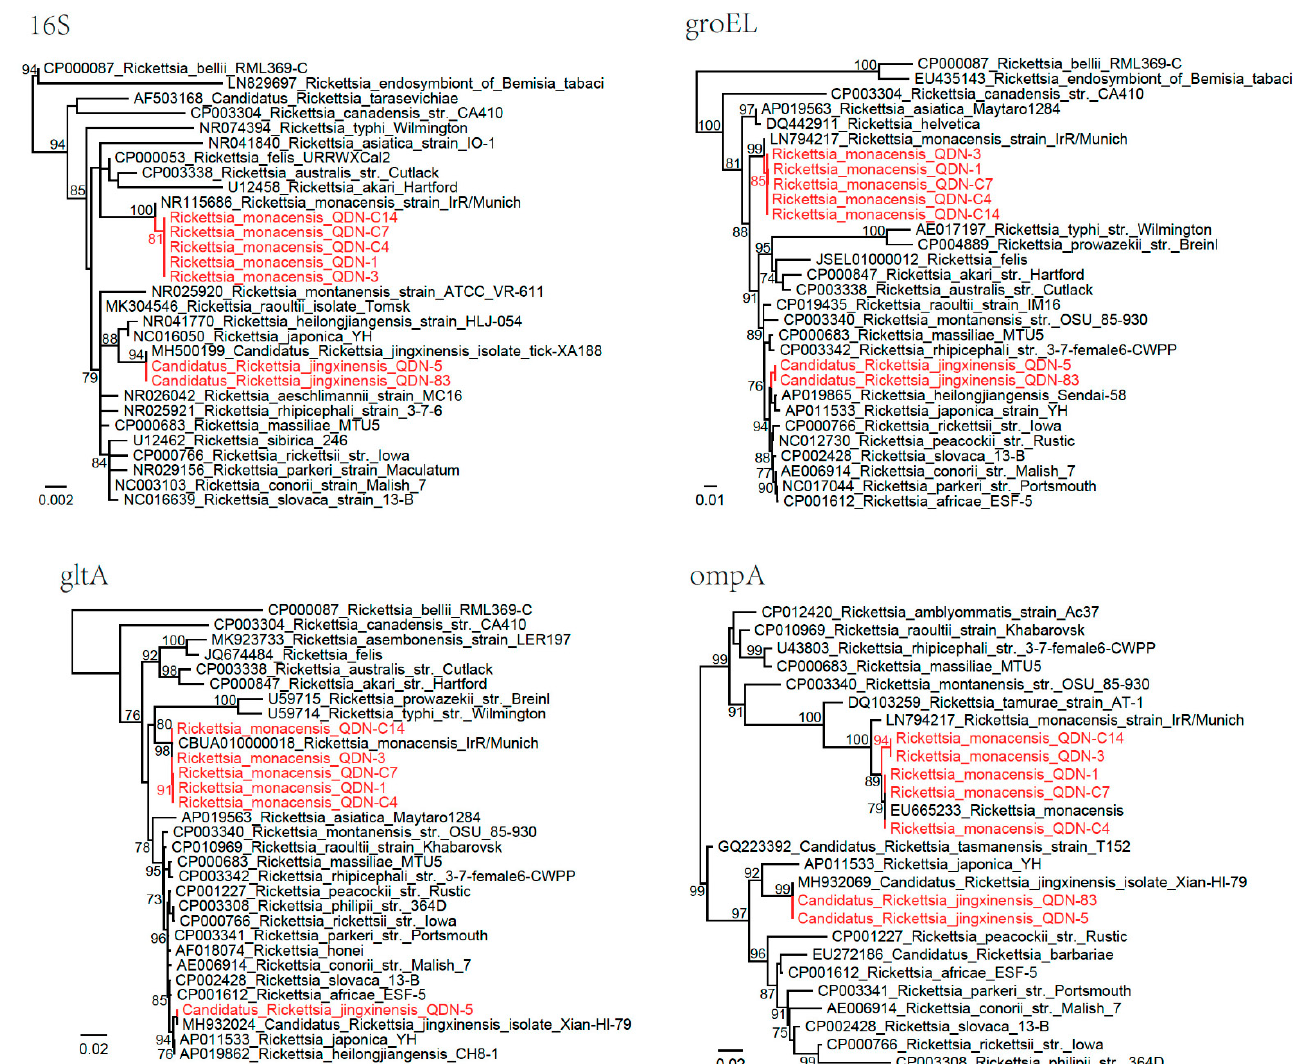
Figure 2. Phylogenetic trees based on the nucleotide sequences of 16S rRNA ( rrs ), groEL , gltA , and ompA genes of Rickettsia isolates. Red: Sequences obtained in this